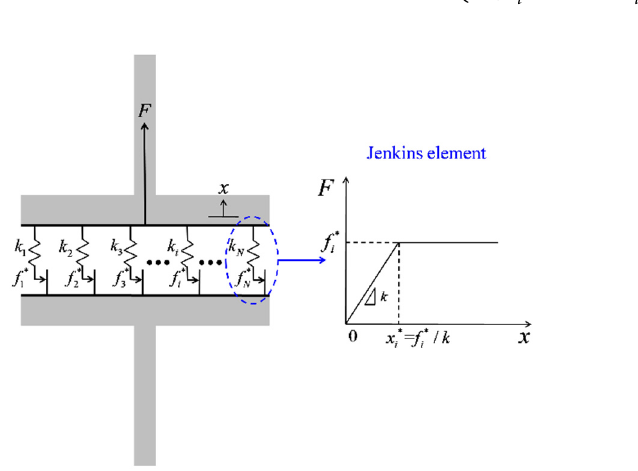
Figure 15. Schematic diagram of mechanical model of T-stubs.